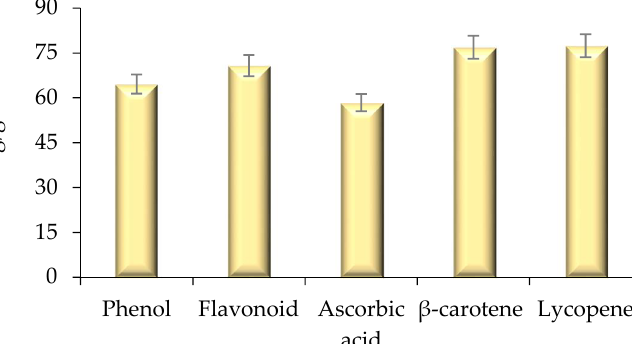
Figure 6. Total phenol, flavonoid, ascorbic acid content, total β-carotene, and lycopene content of modified solvent evaporated Citrus nobilis peel extract. Data are presented as means ± SEM ( n =